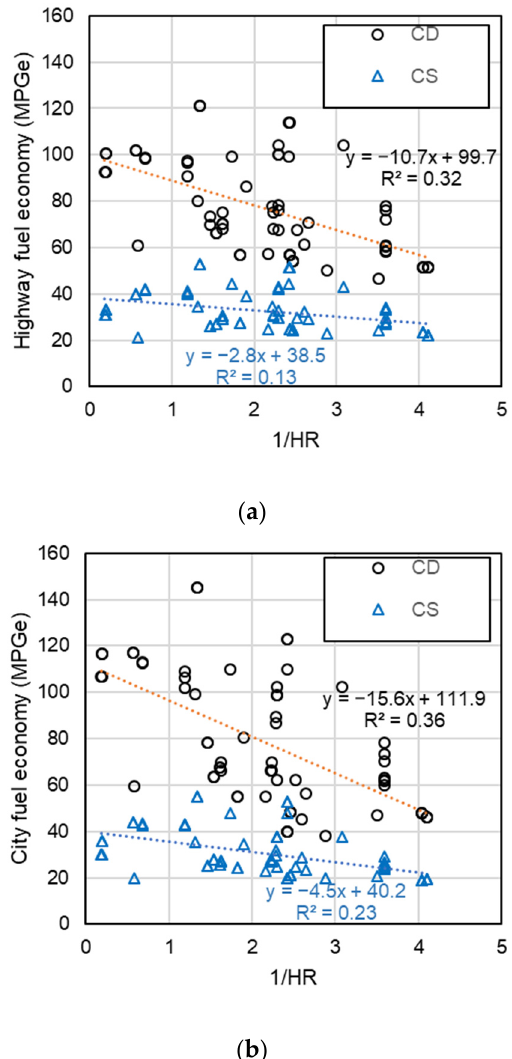
Figure 5. Correlation between hybridization ratio and fuel economy.